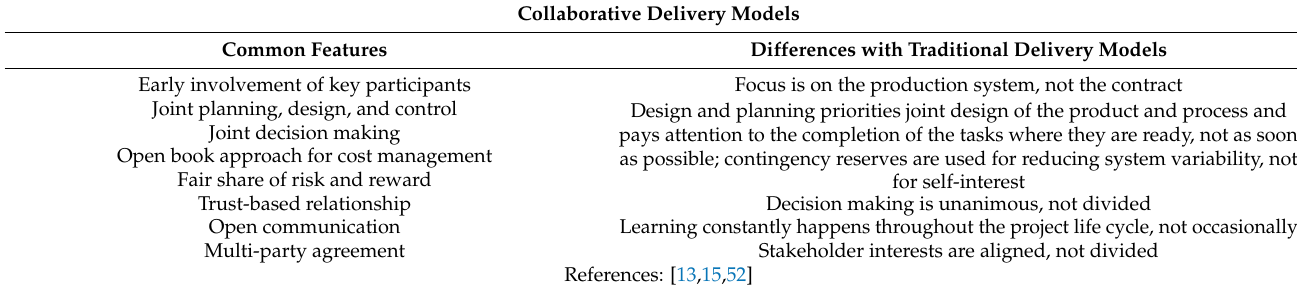
Table 1. Collaborative delivery models: common features and differences with traditional delivery